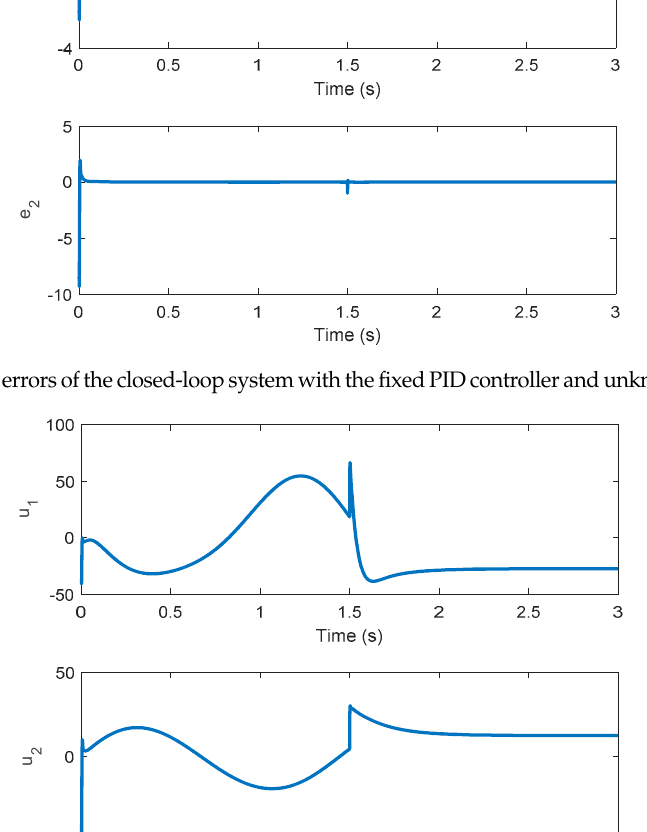
Figure 4. Control inputs based on the fixed PID controller and unknown perturbation.